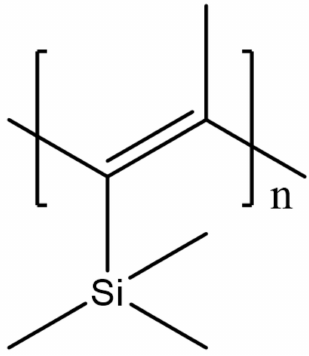
Figure 1. Chemical structure of poly(1-trimethylsilyl-1-propyne)